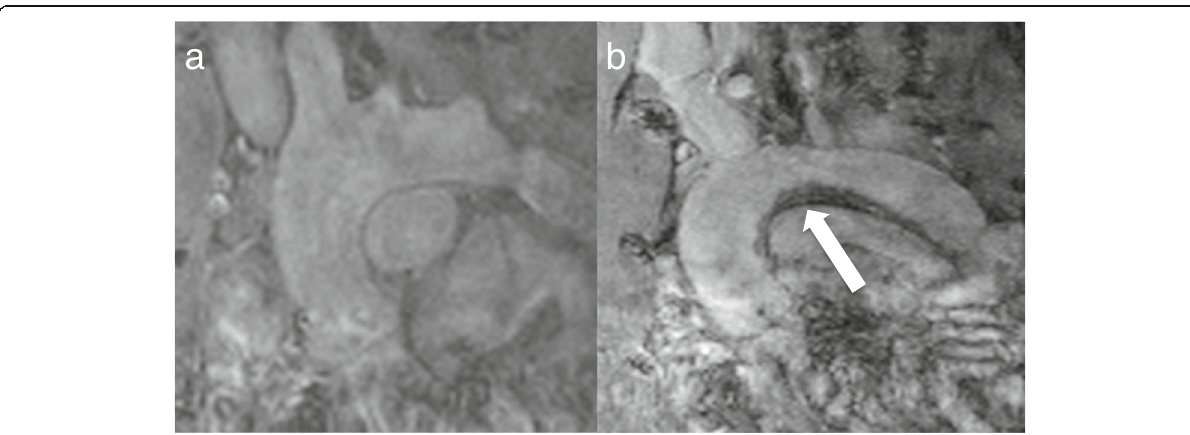
Fig. 5 Aortic arch MPIO- α VCAM-1 binding in an uremic ApoE − / − mice. Telediastolic T2*-weighted MR image acquired before ( a ) and after ( b ) the intravenous injection of 200 μ L microparticles of iron oxide (MPIO) targeted against vascular cell adhesion molecule-1 (VCAM-1). White arrow, MR signal void in aortic arch is due to MPIO- α VCAM-1